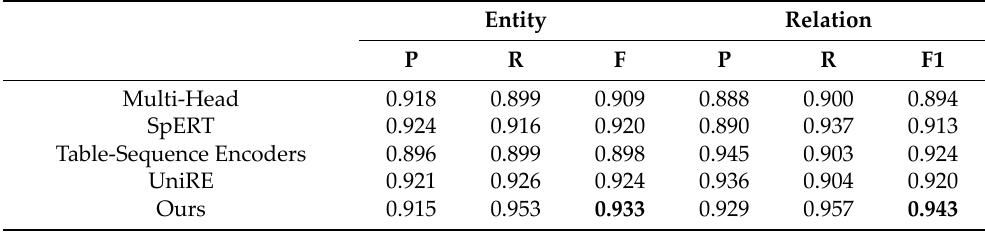
Table 5. Comparative experimental results.